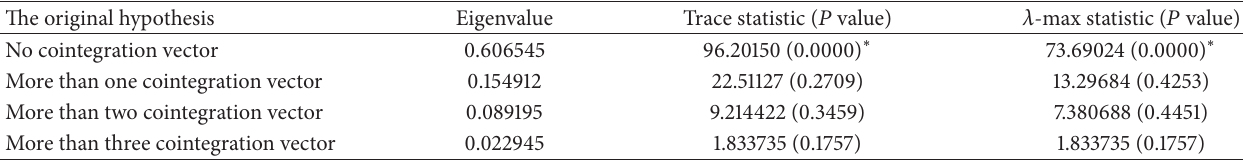
Table 3: The series cointegration test result.